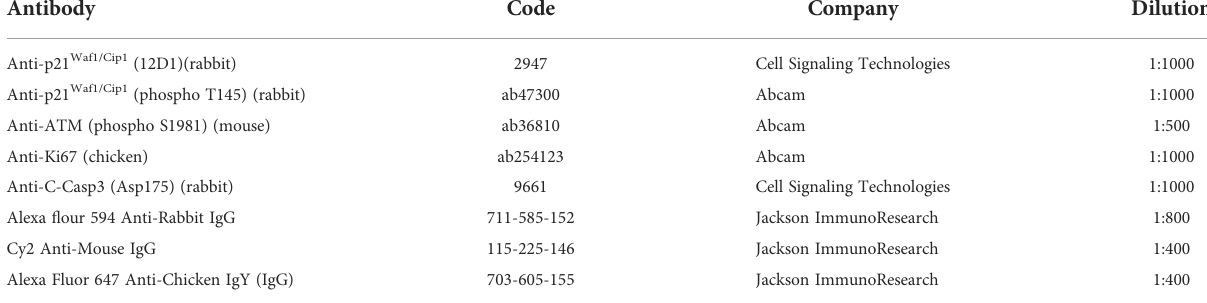
TABLE 2 Antibodies used for immuno fl uorescence. Antibody Code Anti-p21 Waf1/Cip1